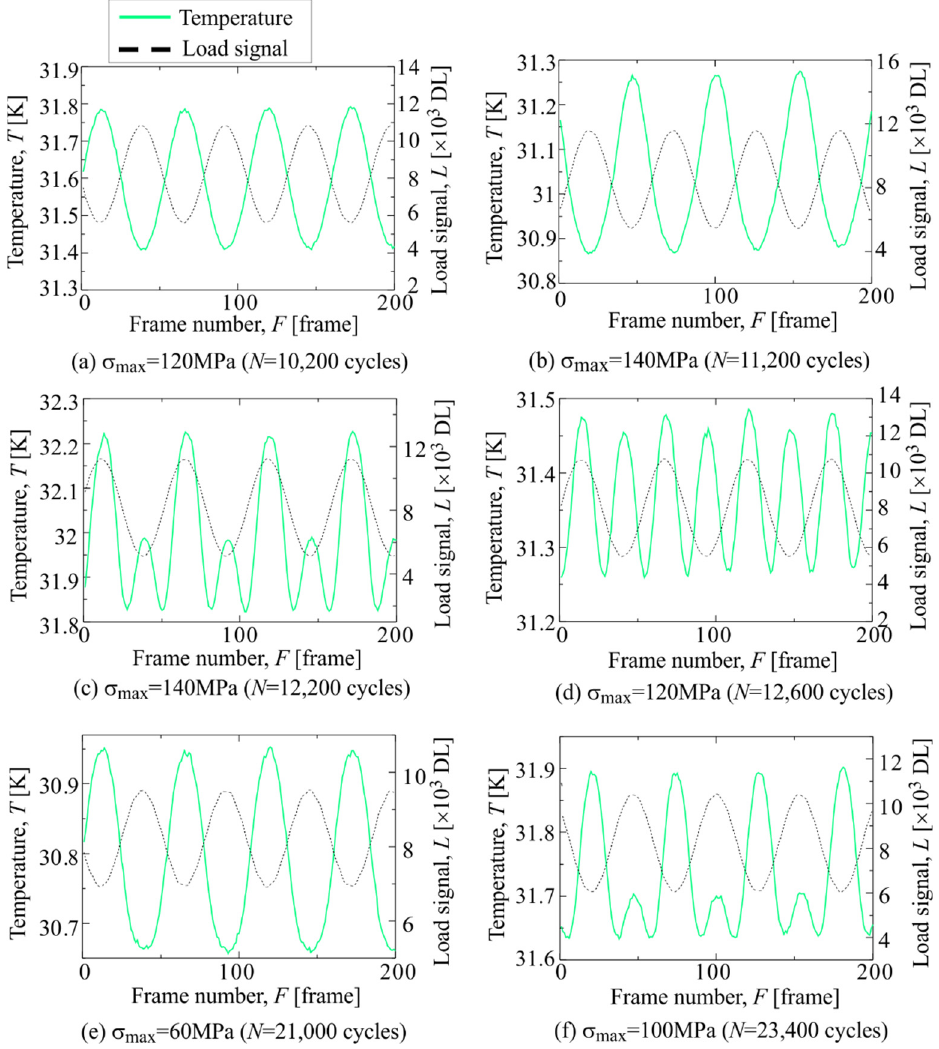
Figure 17. Change in temperature and load signal in Area c-3 measured at ( a ) σ max = 120 MPa and N = 10,200 cycles, ( b ) σ max = 140 MPa and N = 11,200 cycles, ( c ) σ max = 140 MPa and N = 12,200 cy- cles, ( d ) σ max = 120 MPa and N = 12,600 cycles, ( e ) σ max = 60 MPa and N = 21,000 cycles and ( f ) σ max = 100 MPa and N = 23,400 cycles.